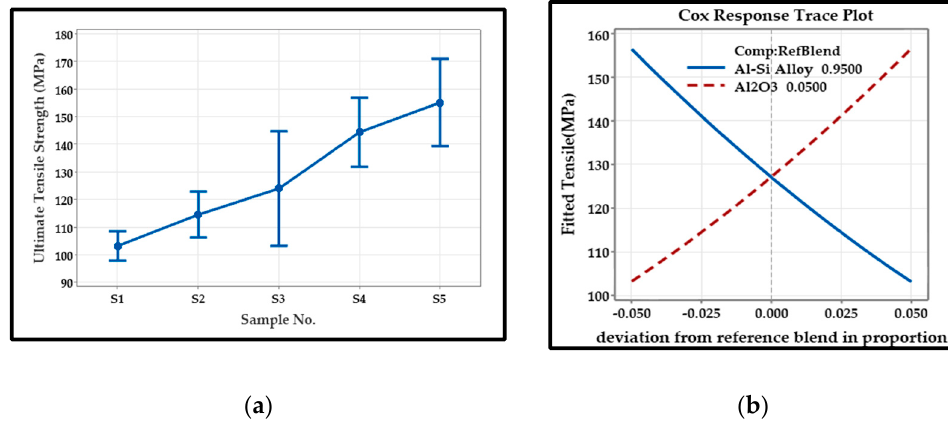
Figure 4. Influence of reinforcements on Tensile Strength. ( a ) Tensile Strength; ( b ) Cox Response Trace.